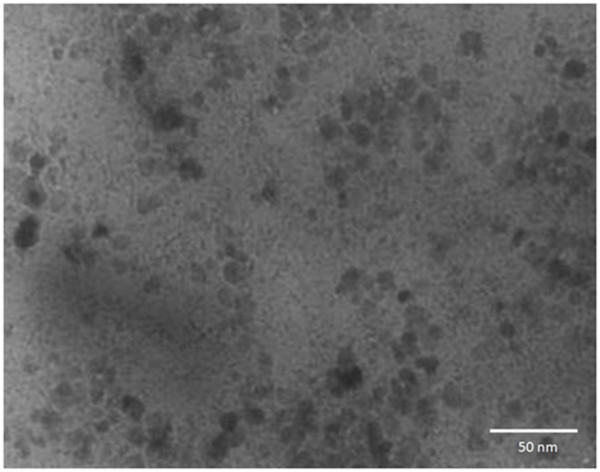
The TEM photo of Fe3O4 nanoparticles.